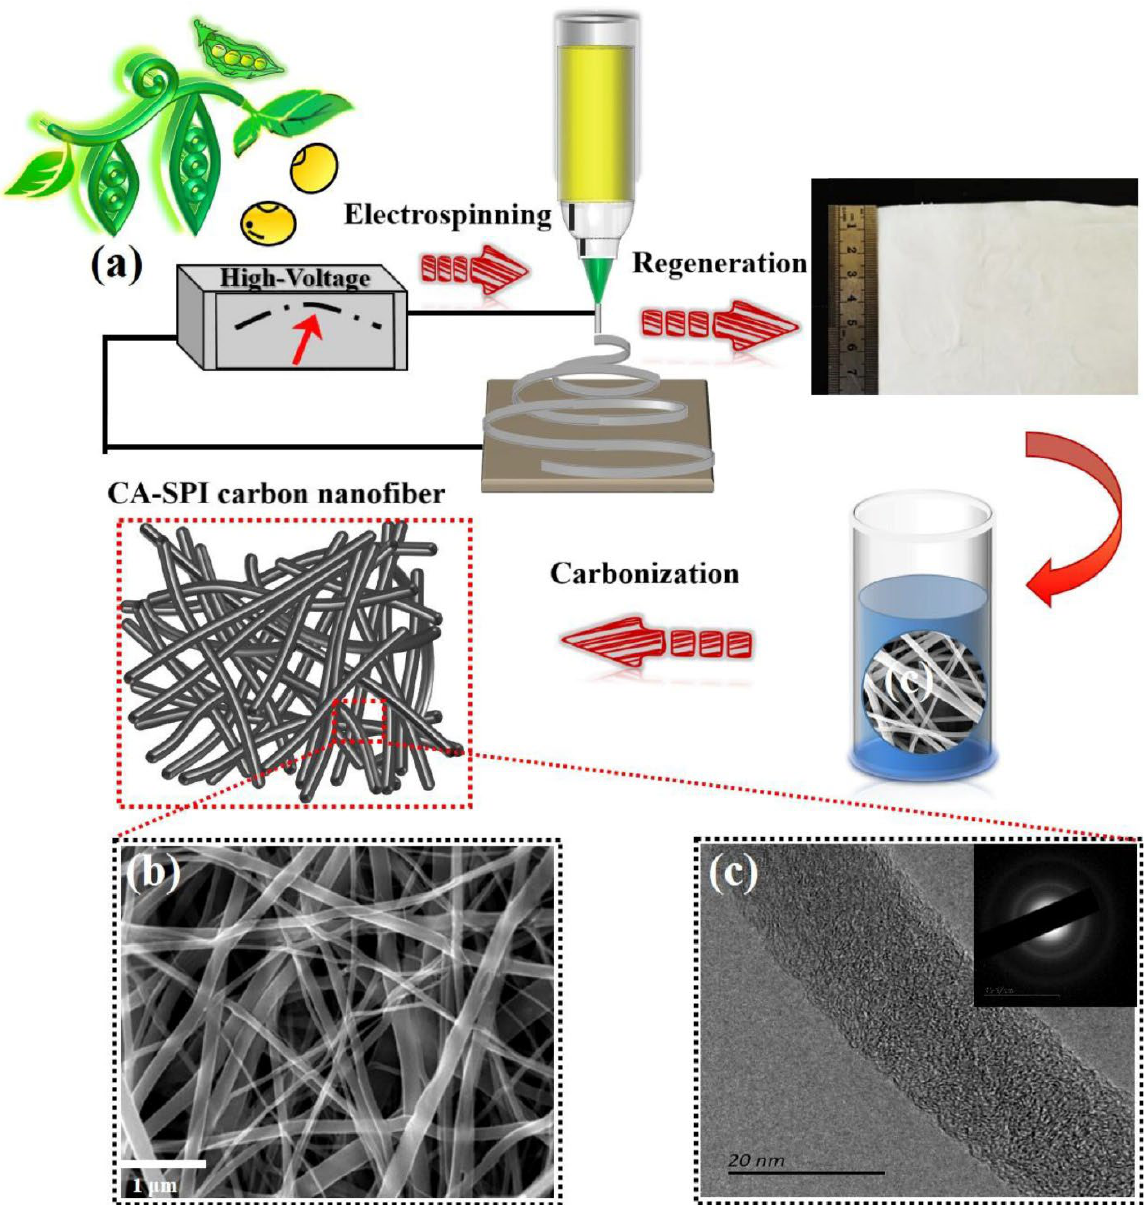
Figure 4. ( a ) Schematic illustration of CA-SPI-CNFs synthesis. ( b ) SEM image of CA-SPI-800 ( c ) TEM image of CA-SPI-800 (Inset is the corresponding SAED pattern). Adapted from reference [29]. This